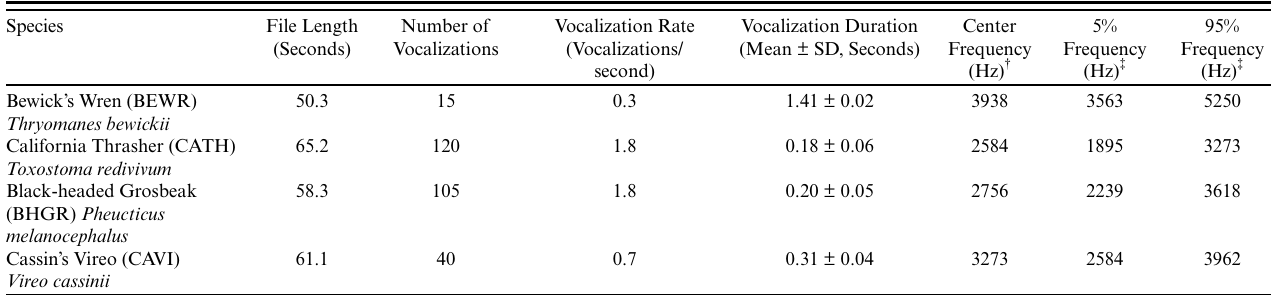
Table 1 . Temporal and frequency characteristics of recordings from four species used as playback stimuli to test the accuracy of the microphone system for direction-of-arrival estimation.